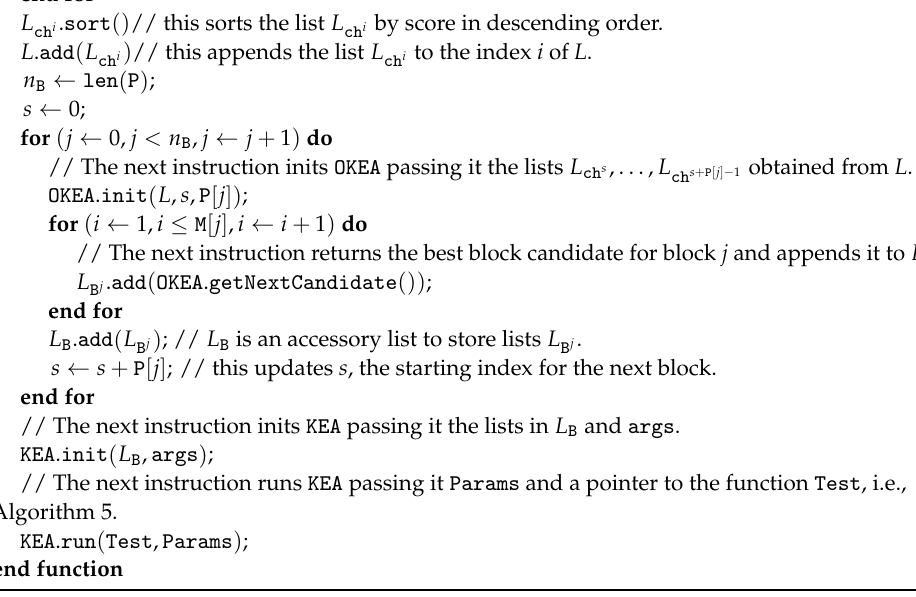
Algorithm 5 Test